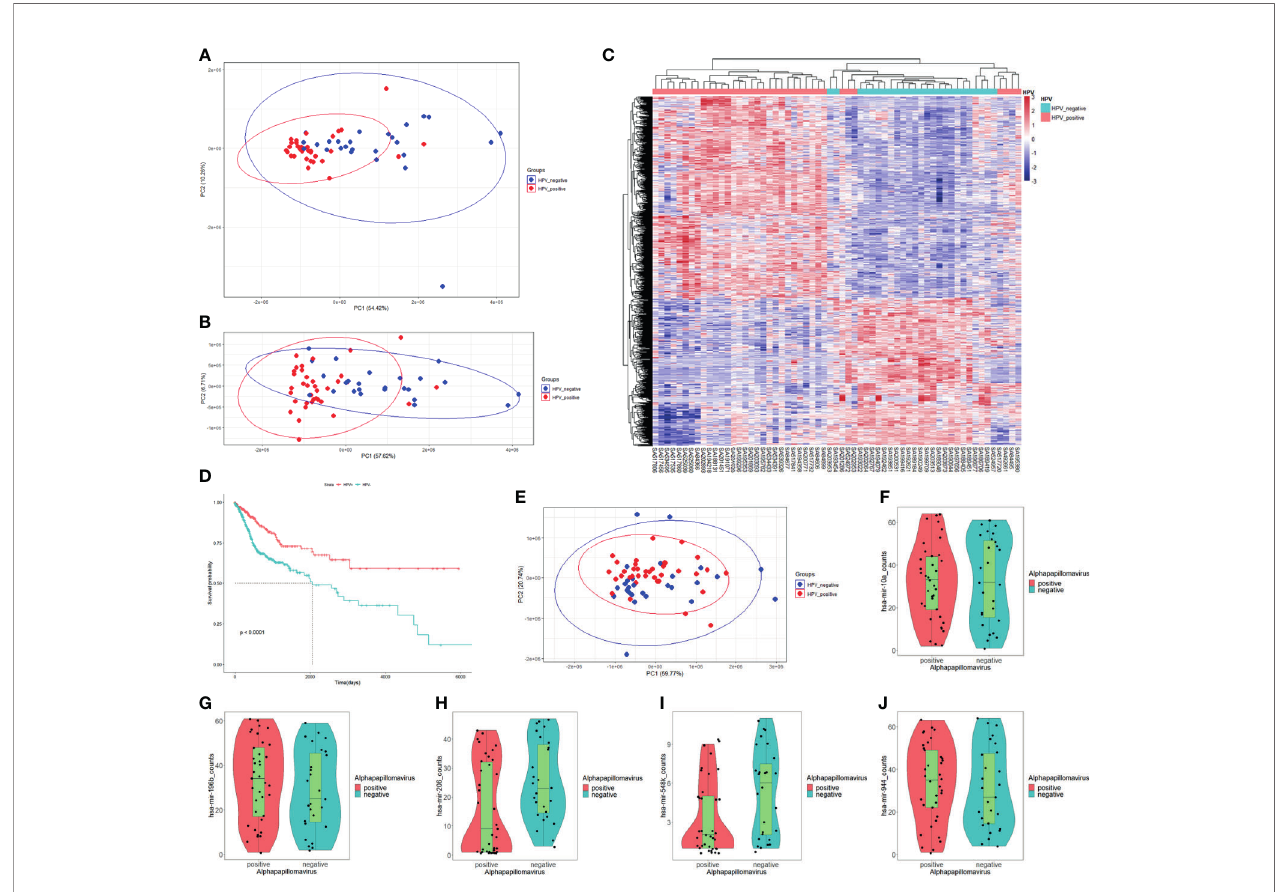
FIGURE 1 | mRNA expression, miRNA expression, and prognosis differences in HPV+ cancers against HPV − cancers. (A) Principal component analysis (PCA) plot of the RNA-Seq data of CESC and HNSC samples within PCAWG program of ICGC database. HPV+ samples are marked in red; HPV − samples are marked in blue. (B) Redrawn PCA plot after outlier was removed. HPV+ samples are marked in red, and HPV − samples are marked in blue. (C) Differentially expressed genes (DEGs) heatmap of HPV+ group vs. HPV − group. Gene FPKMs were scaled with z-score by samples. Pearson ’ s correlation coef fi cients were taken for samples and gene clustering. (D) KM-plot of HPV+ patients and HPV − patient survival status from TCGA CESC and HNSC project. (E) PCA plot of miRNA-Seq data of CESC and HNSC sample within the PCAWG program of ICGC database. HPV+ samples are marked in red, HPV − samples are marked in blue. (F – J) hsa-miR-10a, hsa-miR- 196b, hsa-miR-206, hsa-miR-548k, and hsa-miR-944 expression status in HPV+ samples and HPV − samples